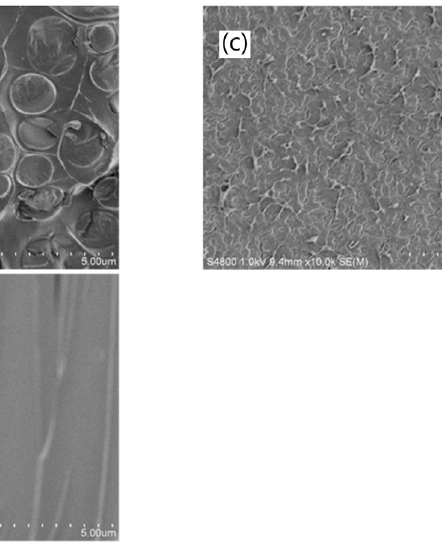
Figure 3. SEM images of the cross-section (×10000) of the membranes: ( a ) pure PVAc, ( b ) PVAc/c-PIL-30, ( c ) PVAc/c-PIL-50, ( d ) PVAc/c-PIL-60, and ( e ) c-PIL. Structural features in the micrometer range are clearly visible [39].